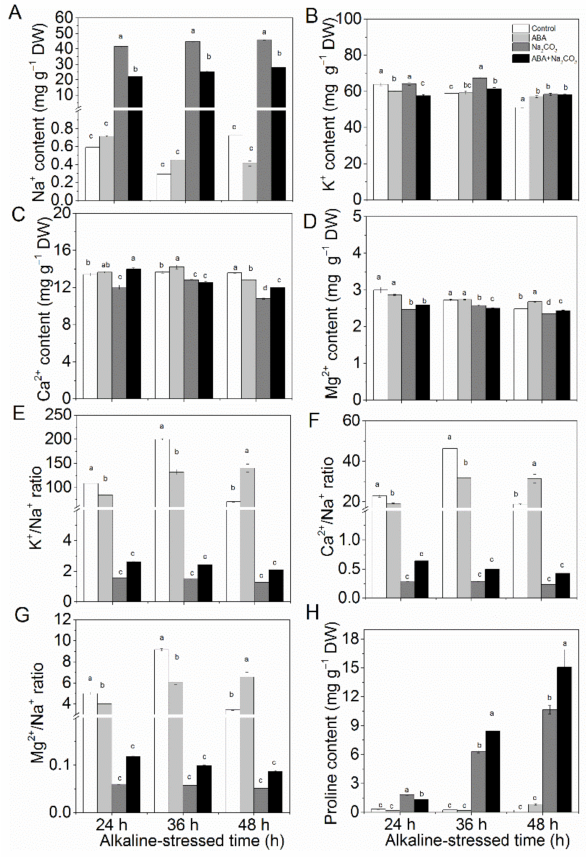
Figure 4. Abscisic acid (ABA) priming regulated ion homeostasis in alfalfa ( Medicago sativa L.) seedlings under alkaline stress. Eighteen-day-old alfalfa seedlings were root-drenched with 10 µ M ABA or without ABA (Control) for 16 h and then exposed to unstressed (Control and ABA) or alkaline-stressed (Na 2 CO 3 and ABA + Na 2 CO 3 , 15 mM Na 2 CO 3 ) conditions. ( A ) Na + content, ( B ) K + content, ( C ) Ca 2+ content, ( D ) Mg 2+ content, ( E ) K + /Na + ratio, ( F ) Ca 2+ /Na + ratio, ( G ) Mg 2+ /Na + ratio, and ( H ) proline contents were determined after 24 h, 36 h, and 48 h of alkaline treatment. Values are the mean ± standard error, n = 3. Different letters above the columns indicate significant differences ( p < 0.05) at each time point based on Duncan’s